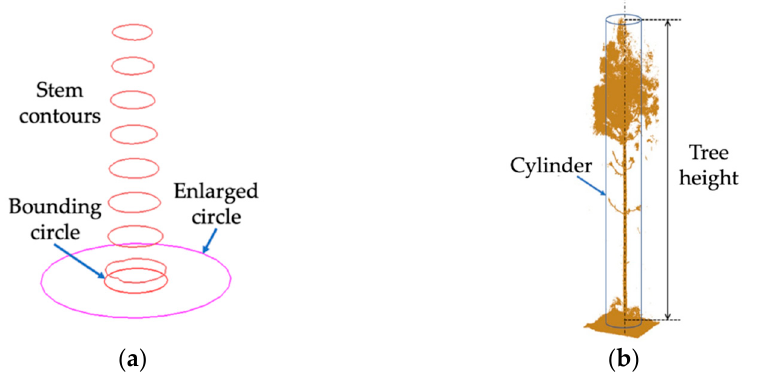
Figure 15. Calculation of tree height. ( a ) Circle on the horizontal plane; ( b ) points in a cylinder.